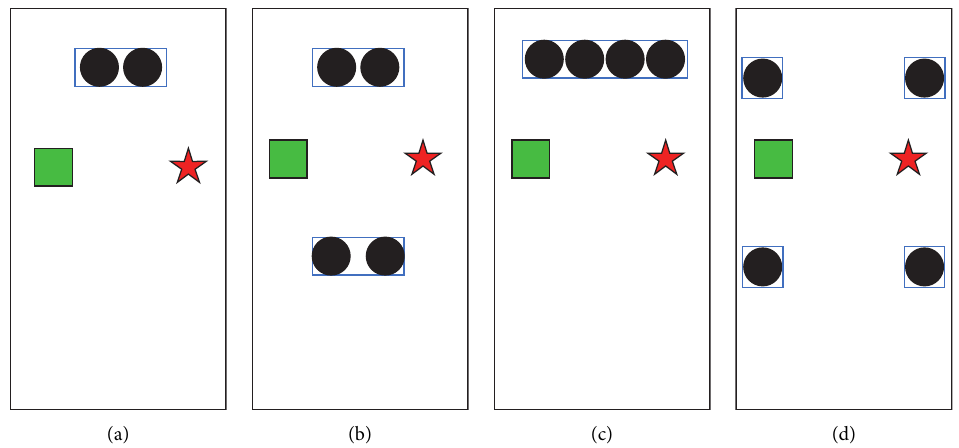
Figure 5: The distribution map of four microphone arrays. (a) Uniform linear 2-channel microphone array. (b) Two-uniform linear distributed 2-channel microphone array. (c) Uniform linear 4-channel microphone array. (d) Distributed 4-channel microphone